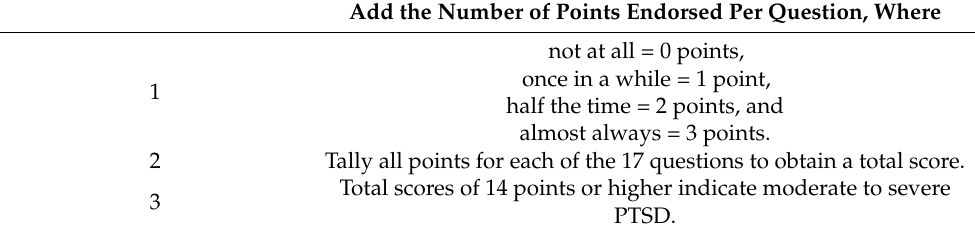
Table 3. Child PTSD Symptom Scale scoring